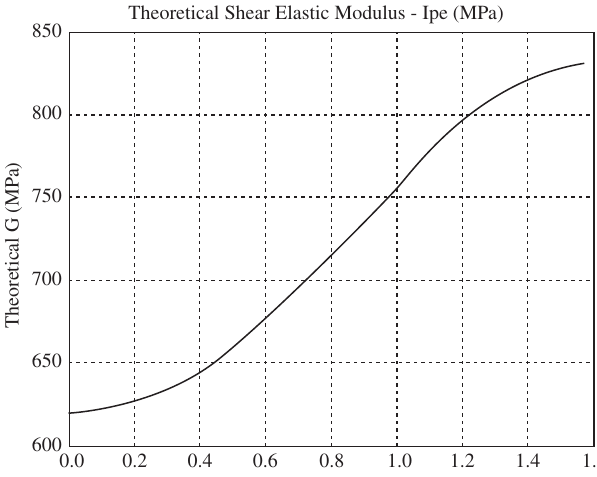
Figure 13. Lateral view diagram of Shear Elastic Modulus and Euler’s angles for Ipê.